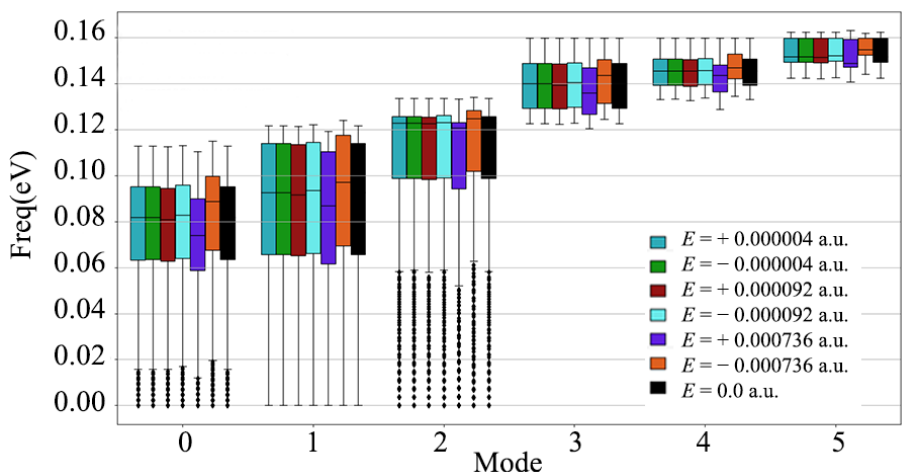
Figure 3. Frequency box plots of 3 acoustic branches and 3 optical branches of diamond, after applying different strength electric fields along the [001] crystal direction.